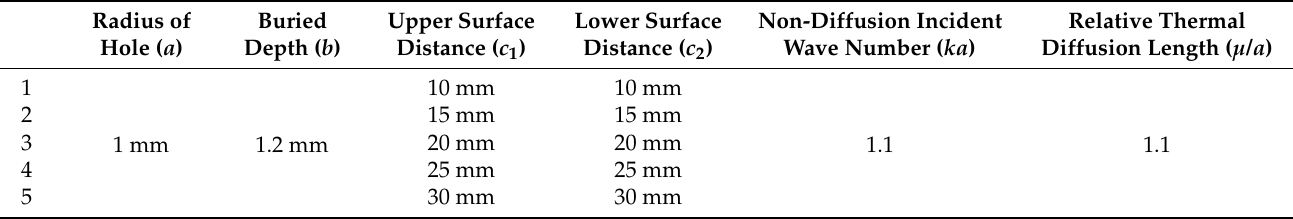
Table 2. Parameters of circular hole and incident light source in the first